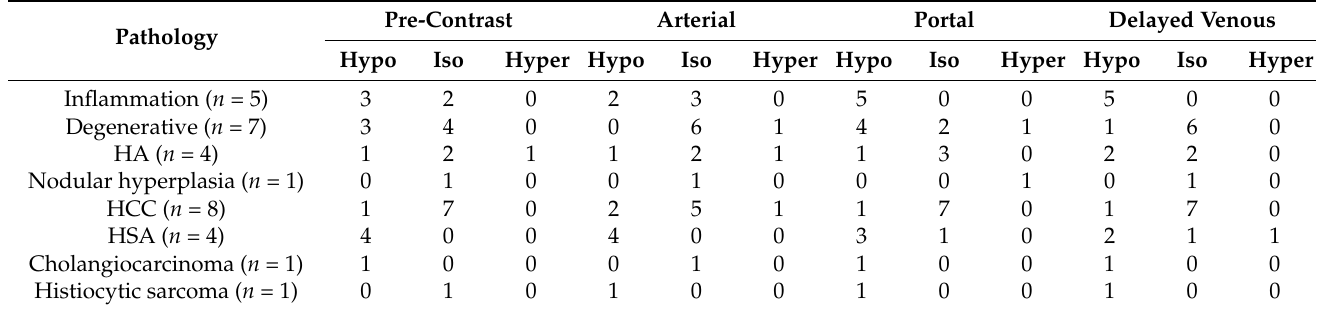
Table 3. The frequency of different attenuation types in the particular pathologies in the different phases of TP-MDCT.